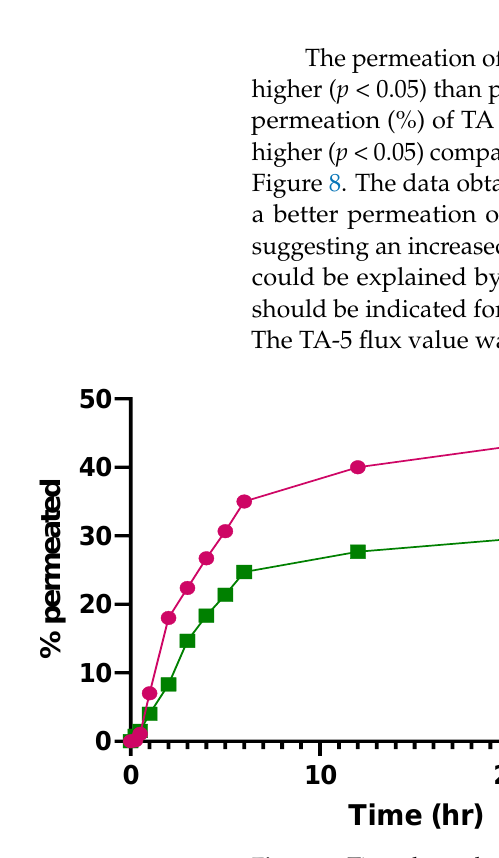
Figure 7. Time-dependent percentage permeation of optimized TAEG (TA-5) and TACG at physiological human skin pH 5.5 and at physiological human temperature (37 ◦ C). Significative differences were observed ( p < 0.05).